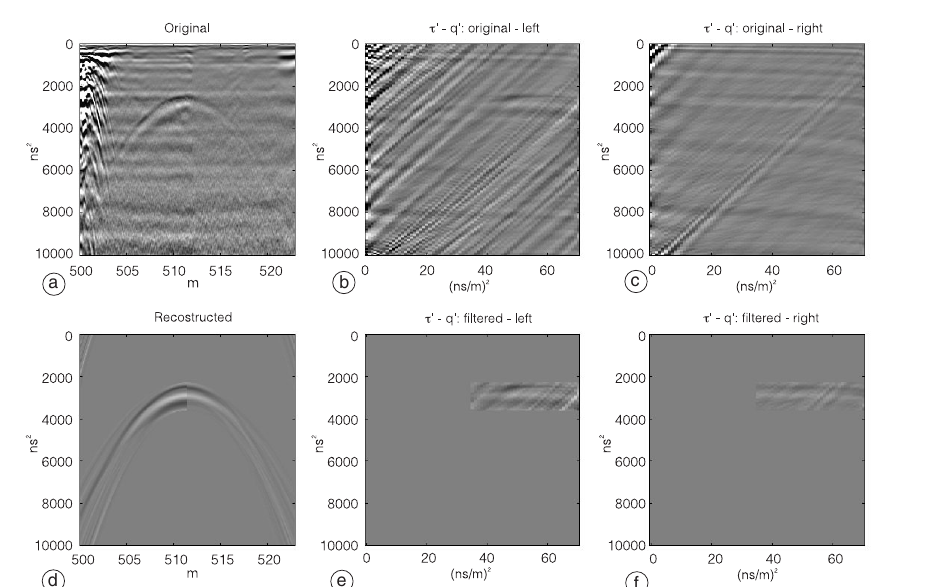
Fig. 8a-f. Example 3: surface-scattering removal by means of the parabolic Radon transform ( t ' -q ' ) in the t 2 -stretched domain.